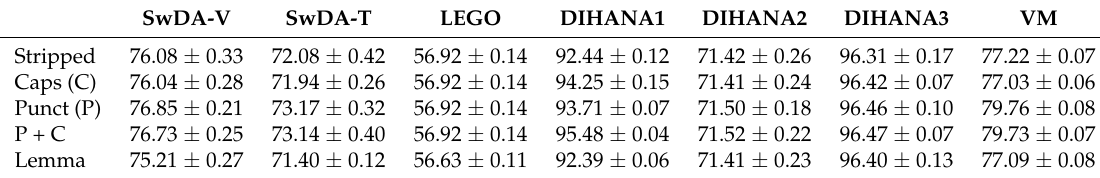
Table 8. Accuracy (%) results obtained using different segment preprocessing approaches. The first row refers to segments stripped of punctuation and capitalization information. The second row refers to segments containing capitalization information, while the third row refers to segments containing punctuation. The fourth row combines both punctuation and capitalization information. The last row refers to lemmatized segments stripped of punctuation and capitalization